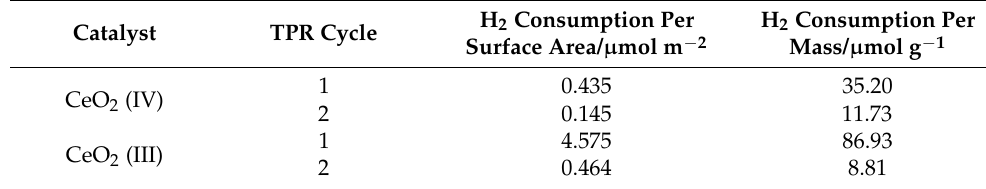
Figure 8. Temperature programmed reduction profiles of CeO 2 (IV) and CeO 2 (III) catalysts. Condi- Table 2. H 2 Consumption of CeO 2 (IV) and CeO 2 (III) catalysts determined from temperature programmed reduction.